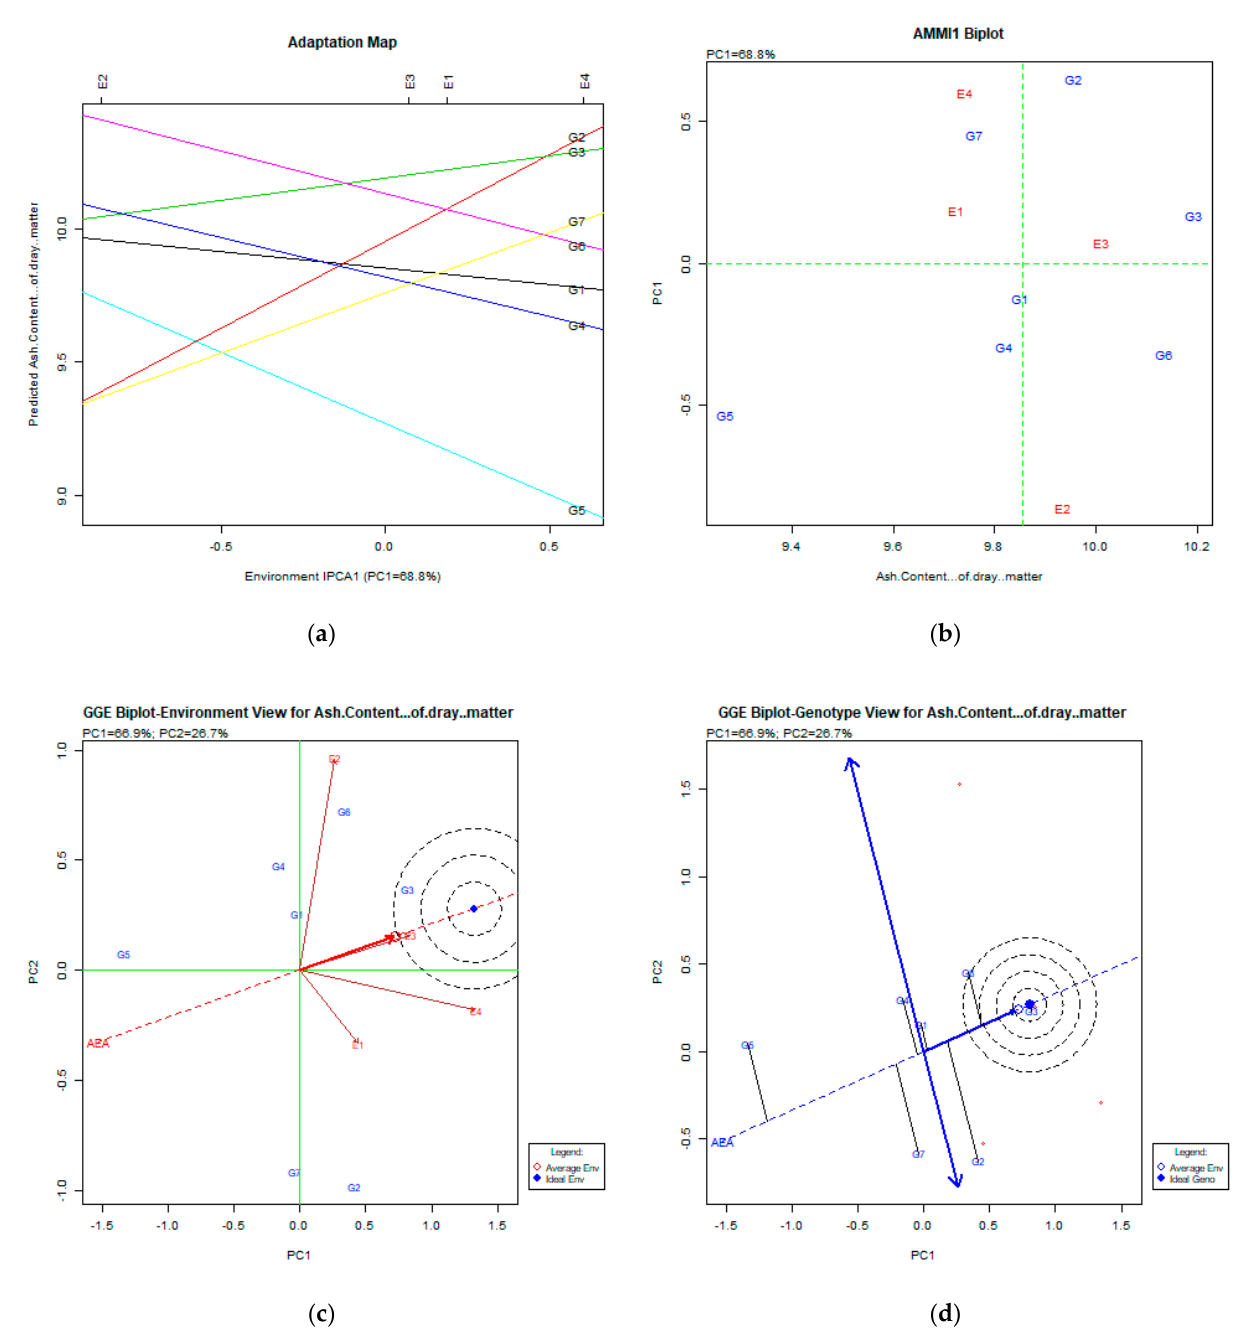
Figure 7. Stability analysis for the trait of ash content % of dry matter based on: ( a ) adaptation map, where the environmental stability of the genotypes is visualized by the X -axis (PC1) and the performance of the trait for the genotypes is tested by the Y -axis; ( b ) AMMI1 biplot, where the environmental stability of the genotypes is visualized by the X -axis (PC1) and the performance of the trait for the genotypes is tested by the Y -axis; ( c ) GGE biplot depicting the environmental stability over time for the desirable genotypes placed near the ideal environment; ( d ) GGE biplot for genotypes depicting the genotypic stability in different environments. The desirable genotypes are those placed near the concentric region of the ideal genotype.